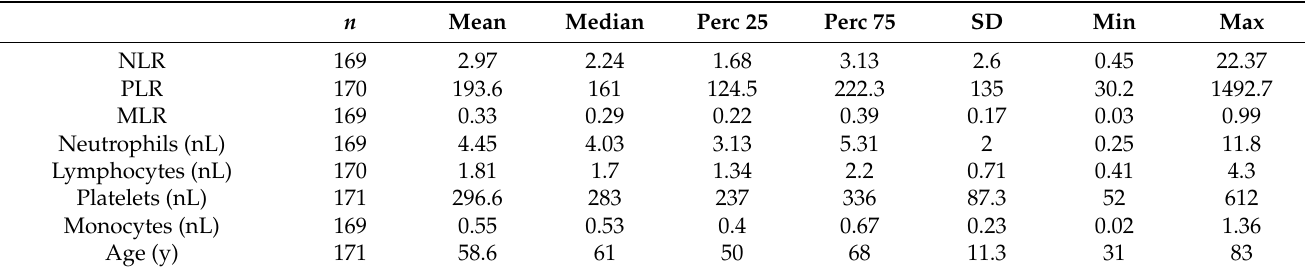
Table 2. Cut-off values for peripheral blood cell counts and their ratios. Cut-off levels for blood values of all patients were determined by the 75% percentile (gray column). MLR: monocyte-to-lymphocyte ratio; NLR: neutrophil-to-lymphocyte ratio; PLR: platelet-to-lymphocyte